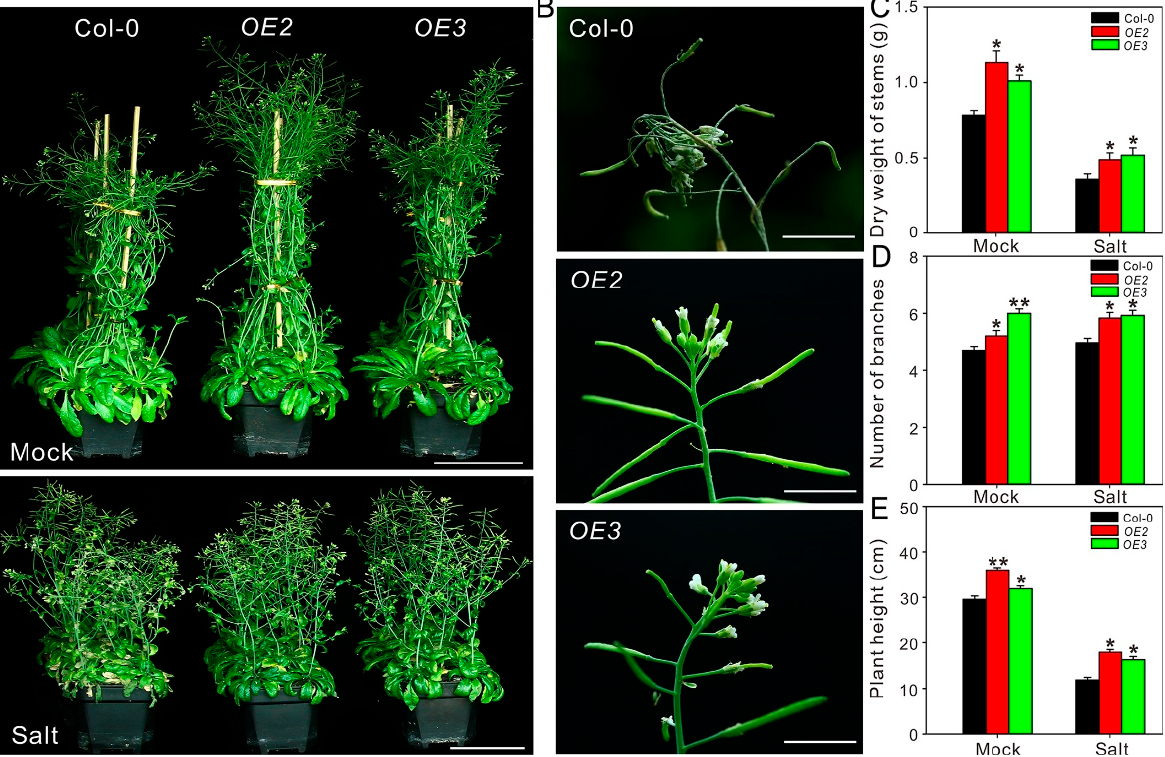
Figure 3. Overexpression of ZxPIP1;3 improves growth vigor under salt treatment. ( A ) Phenotypes of soil-cultured seedlings treated with (Salt) or without (Mock) 100 mM NaCl for 20 days. Bar = 10 cm. ( B ) Phenotypes of shoot apices of plants under salt treatment as described in ( A ). Bar = 1 cm. ( C – E ) Dry weight of stems ( C ), number of branches ( D ) and plant height ( E ) of plants described in the legend of ( A ). For ( C–E ), asterisks indicate significant differences from Col-0 ( n = 13 per column. * p < 0.05, ** p < 0.01, one way ANOVA).